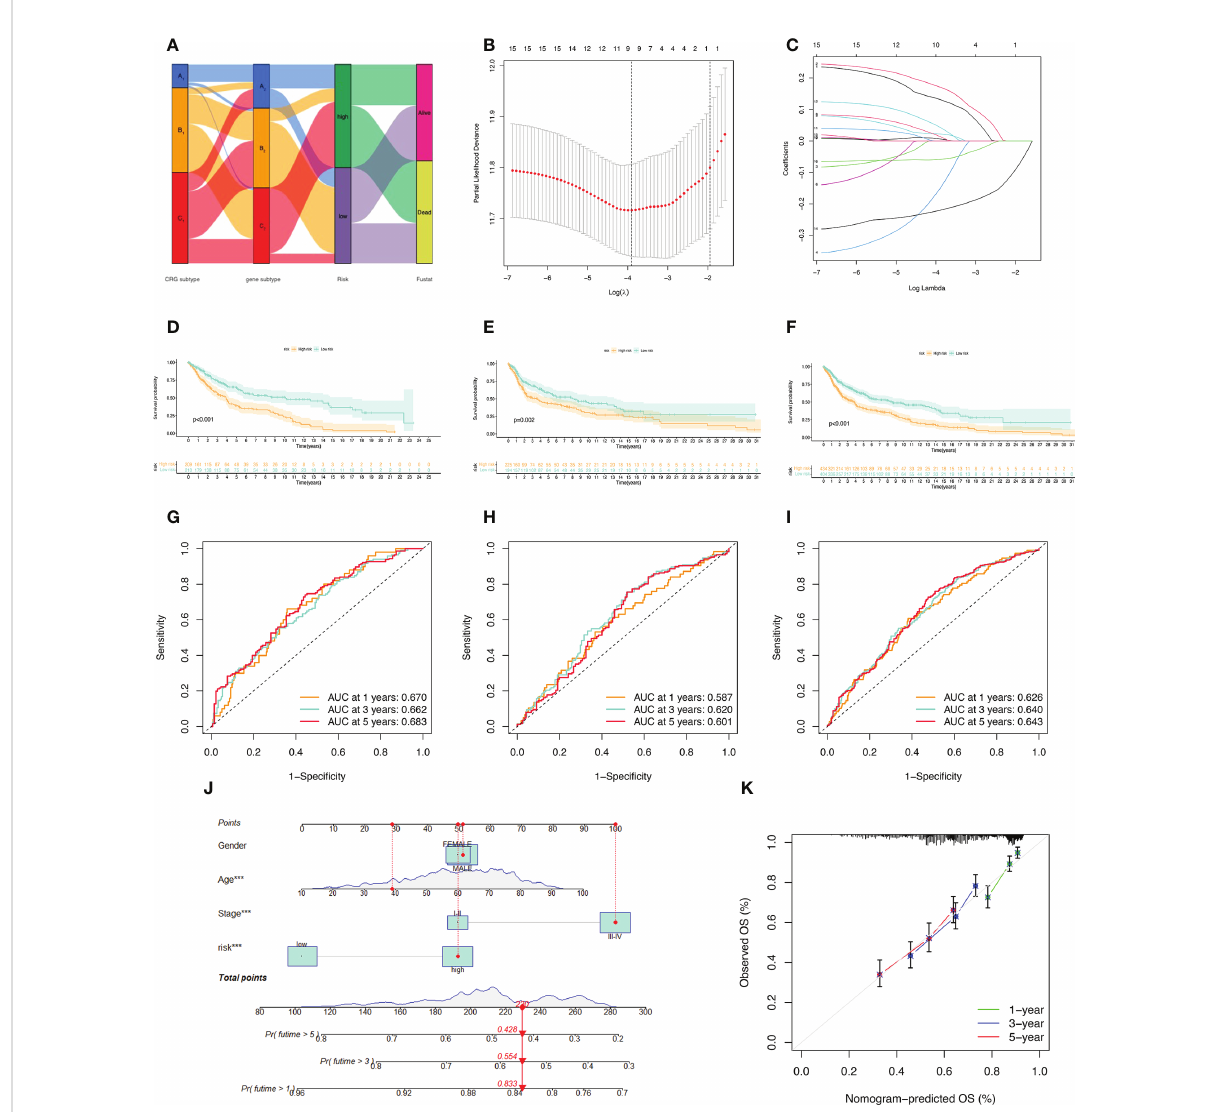
FIGURE 4 Construction of the prognostic model. (A) Sankey diagram to describe the process of constructing a prognostic model based on CRGs- subtypes and gene subtypes. (B, C) Prognostic genes were screened using LASSO regression. (D, G) Kaplan Meier analysis of OS in melanoma patients in the training set; ROC curves for 6 key variable genes. (E, H) OS of melanoma patients in Kaplan Meier analysis validation set; ROC curves of 6 key variable genes. (F, I) Kaplan Meier analysis of OS in all melanoma patients; ROC curves of 6 key variable genes. (J) Nomograms predicting 1-, 3-, and 5-year OS probabilities in melanoma patients. (K) Calibration plots of the